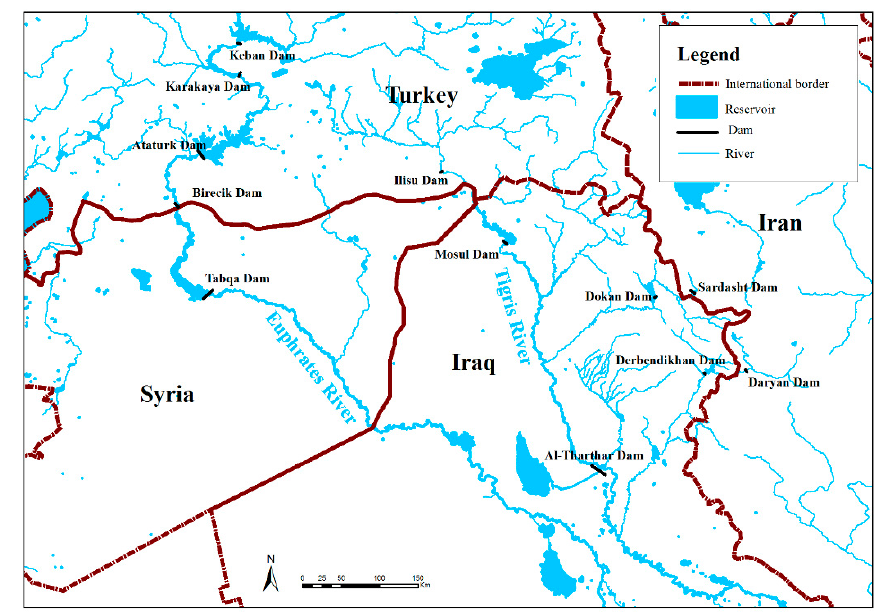
Figure 2. Dams with the greatest impact in upstream countries (Turkey and Iran) and the most affected dams in downstream countries (Syria and Iraq).